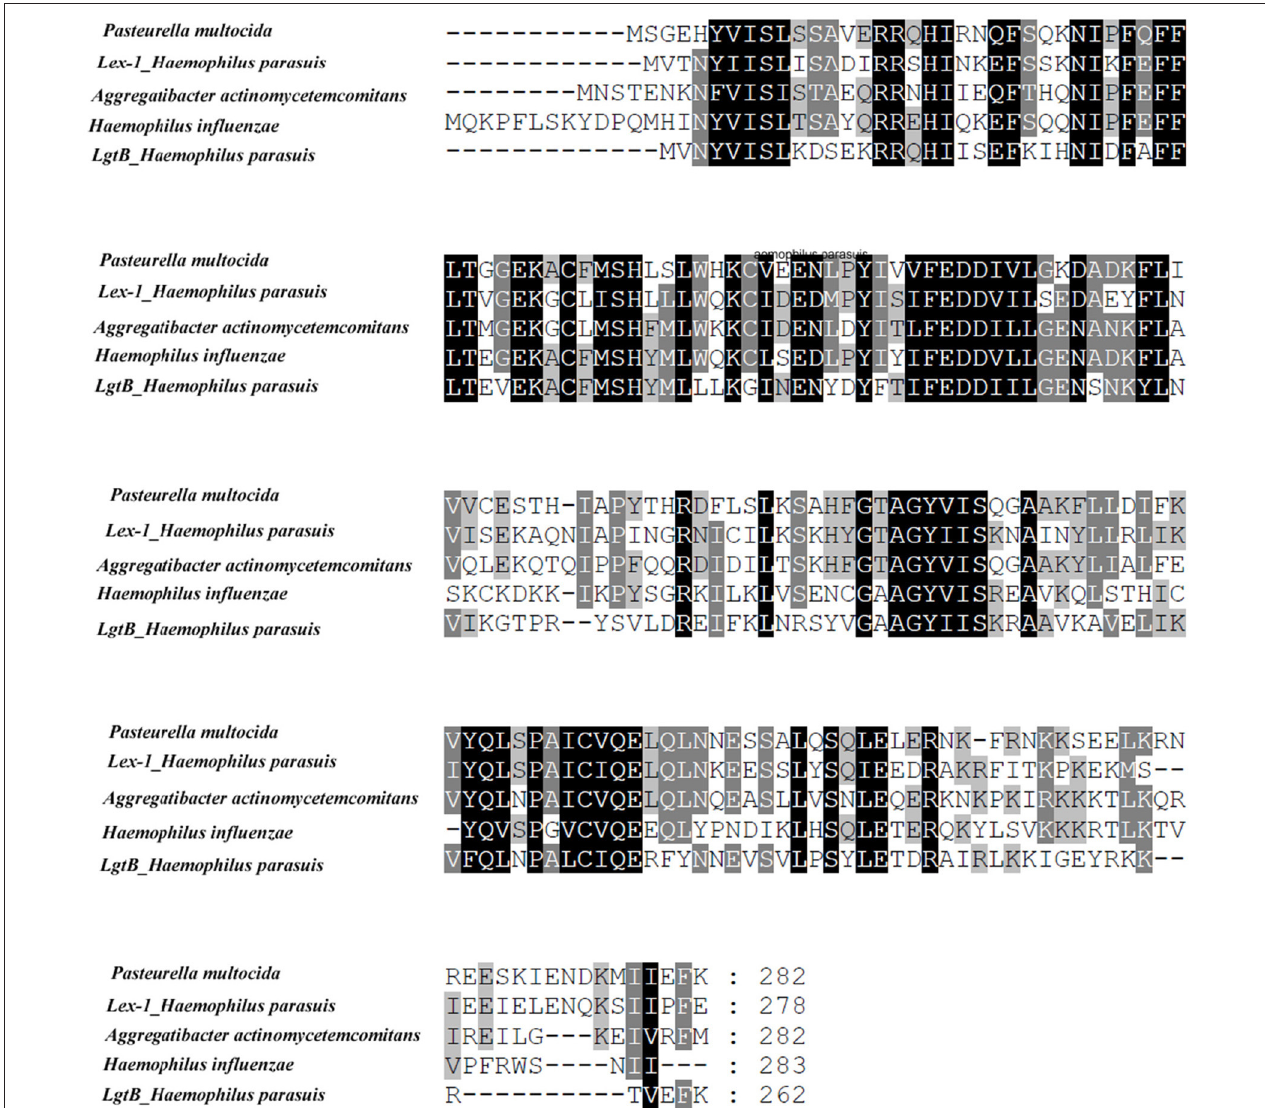
FIGURE 1 | Multiple alignments of the lex-1 or lgtB amino acid sequences from H. parasuis SC096 with those from Pasteurella multocida (no. WP_014390682.1), Aggregatibacter actinomycetemcomitans (no. WP_053330004.1), Haemophilus influenza (no. WP_048952714.1). Shadowed letters indicated either identical residues or conservative